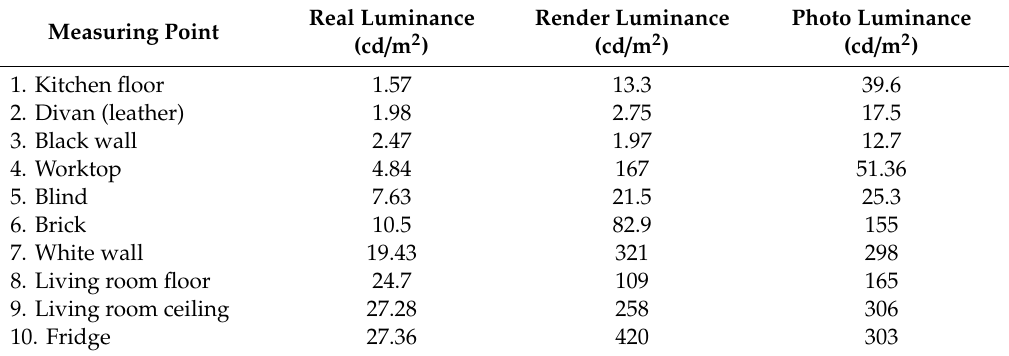
Table 1. Luminance levels at measuring points